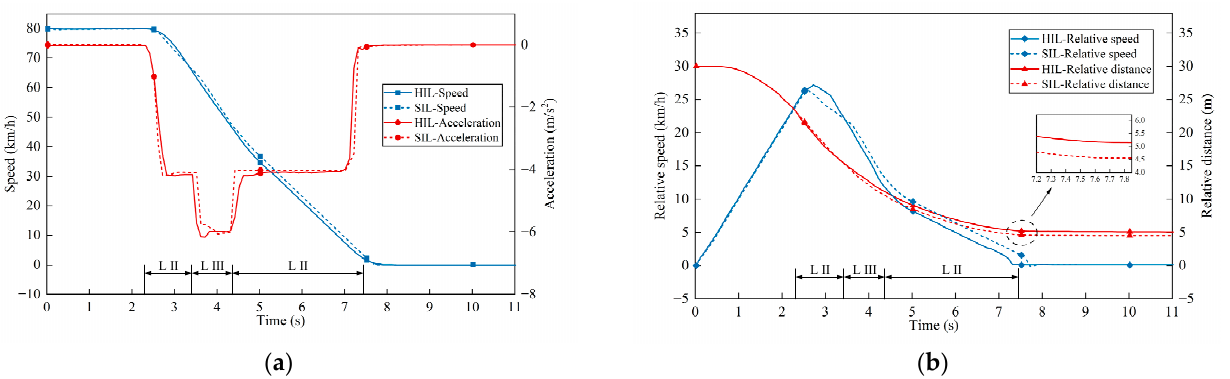
Figure 12. HIL testing and SIL testing results of CCRb condition: ( a ) speed of VUT and acceleration of VUT; ( b ) relative speed and relative distance. of VUT; ( b ) relative speed and relative